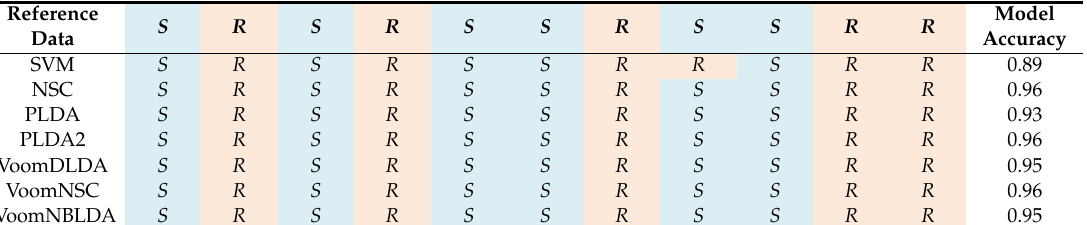
Table 1. Prediction of testing data sets. S (susceptible) and R (resistant / tolerant) refer to reference dataset. SVM predict 10 out of 11 samples, being the less accurate model. The training set model accuracy was calculated fractionating the number of correct predictions (true positive + true negative) by the total number (true positive + true negative + false positive + false negative) and using the sparsity values for the proportion of features used in training each